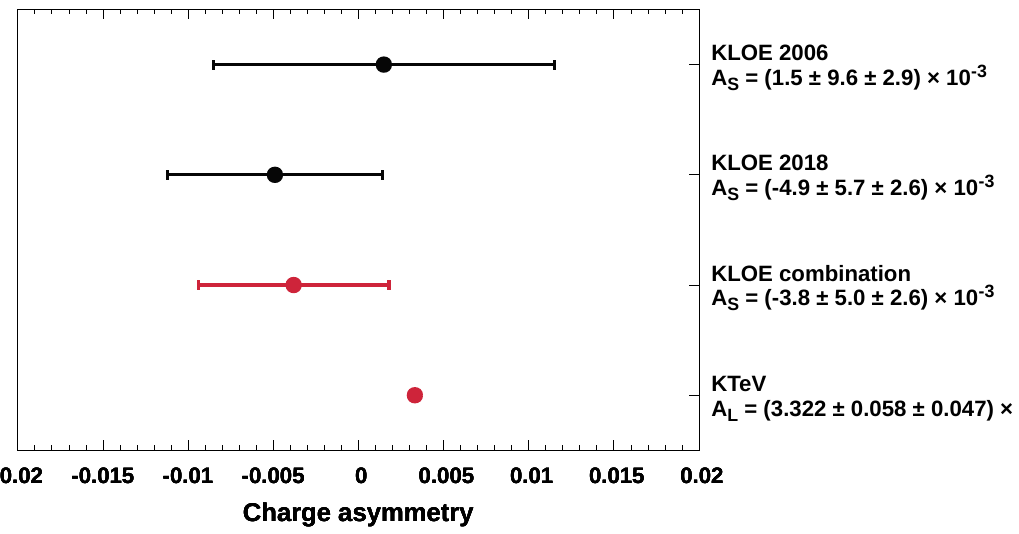
Figure 5 . Comparison of the previous result for A S (KLOE 2006 [17]), the result presented in this paper (KLOE 2018) and the combination of the two. The KTeV result for A L [14] is also shown. The uncertainties of the points correspond to the statistical and systematic uncertainties summed in